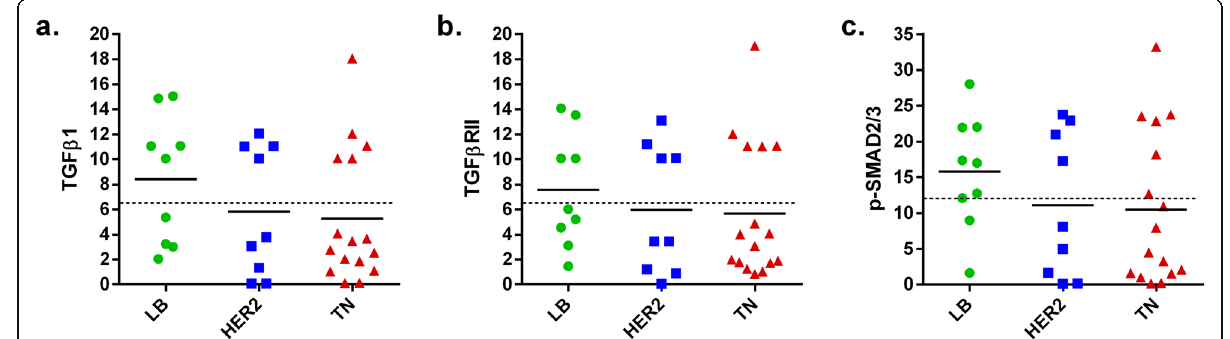
Fig. 2 Immunostaining scores for TGF β 1 ( a ), TGF β RII ( b ) and p-SMAD2/3 ( c ) among BC molecular subtypes. Data is represented as the mean percentage of positive area in 3 fields analyzed per slide. Black lines represent the mean for each subtype. Dashed lines represent the mean for TGF β 1 ( a ; 6.253), TGF β RII ( b ; 6.294) and p-SMAD2/3 ( c ; 12.056) considering all BC samples. LB: Luminal-B-HER2 + subtype. HER2: HER2-enriched subtype. TN: triple-negative